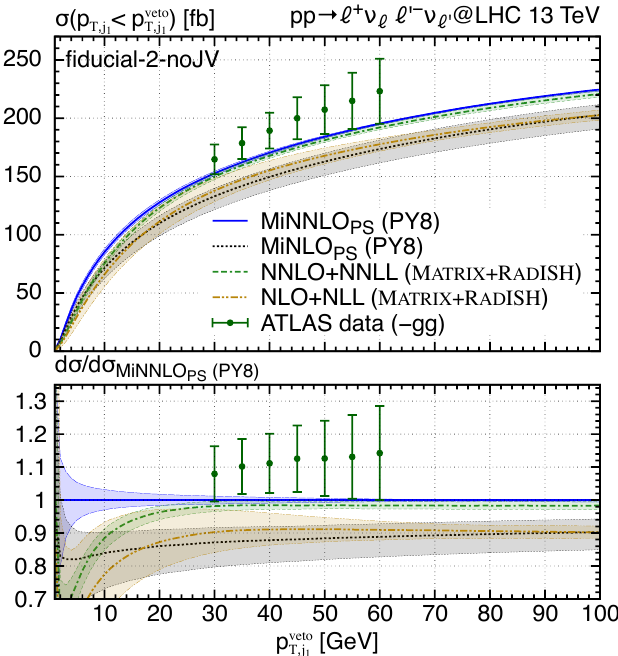
Figure 12. Jet-vetoed cross section in the fiducial-2-noJV phase space compared to data. As described in the caption of table 2 the data has been adjusted by subtracting the gg LO contribution quoted in table 2 of ref. [124] and by dividing out a factor of